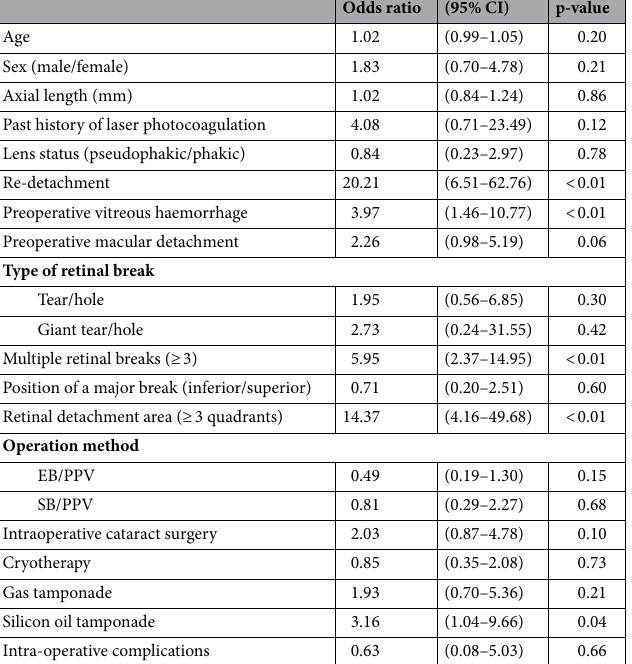
Table 2. Univariate analysis of risk factors for macular pucker. EB, encircling buckle; PPV, pars plana vitrectomy; SB, segmental buckle.